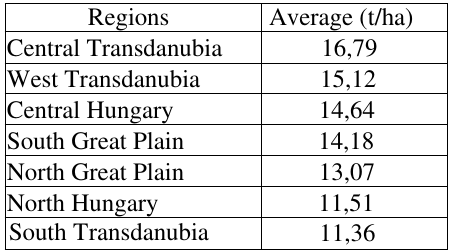
Table 1: Level of apple production in the different